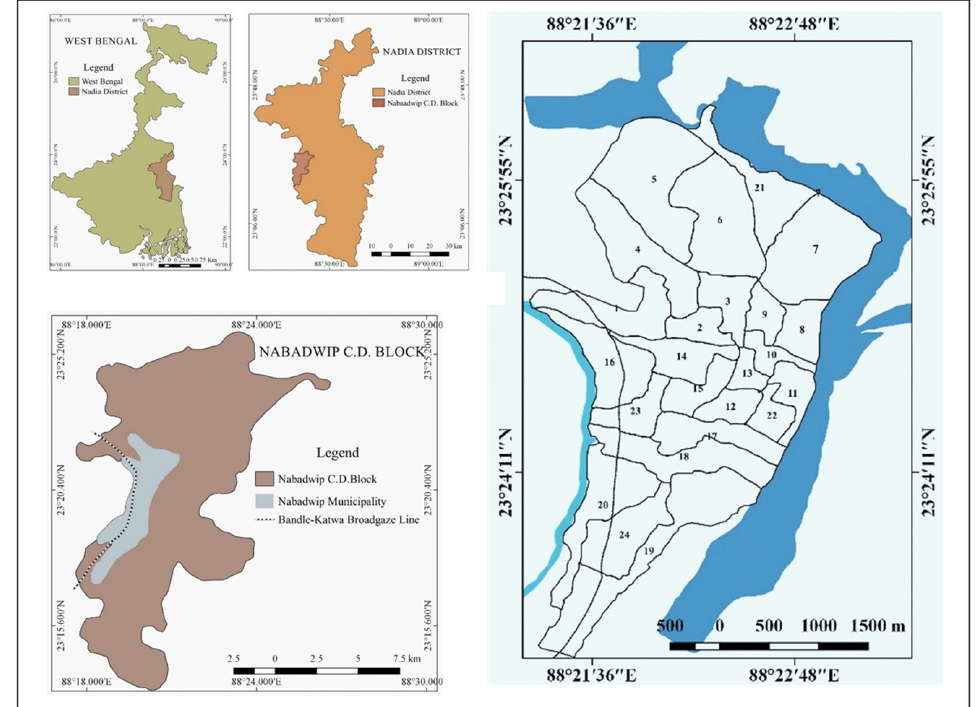
Figure 1. Location map of the study area.